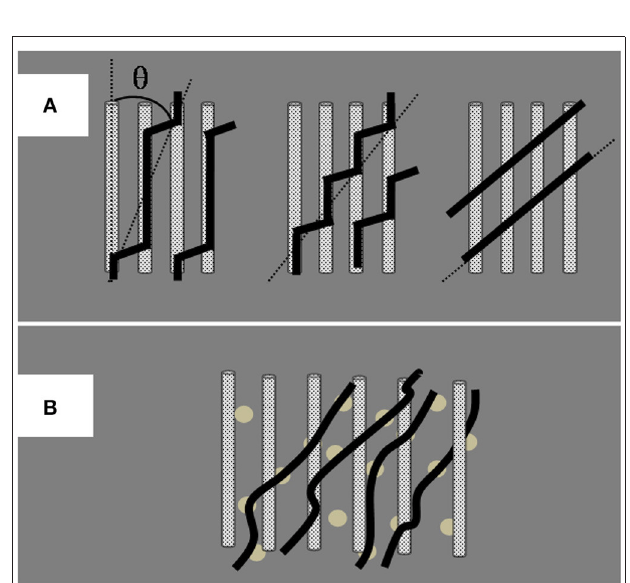
FIGURE 14 | Schematic illustration of (A) possible vortex configurations for varying inclinations of applied magnetic field ( θ ) with respect to the columnar disorders aligned along the c- axis of the YBCO films and (B) pinning of vortices provided by spherical nanoparticles located randomly between the columnar disorders in the YBCO matrix. Reproduced from Jha et al. [131], with the permission from IoP Publishing.